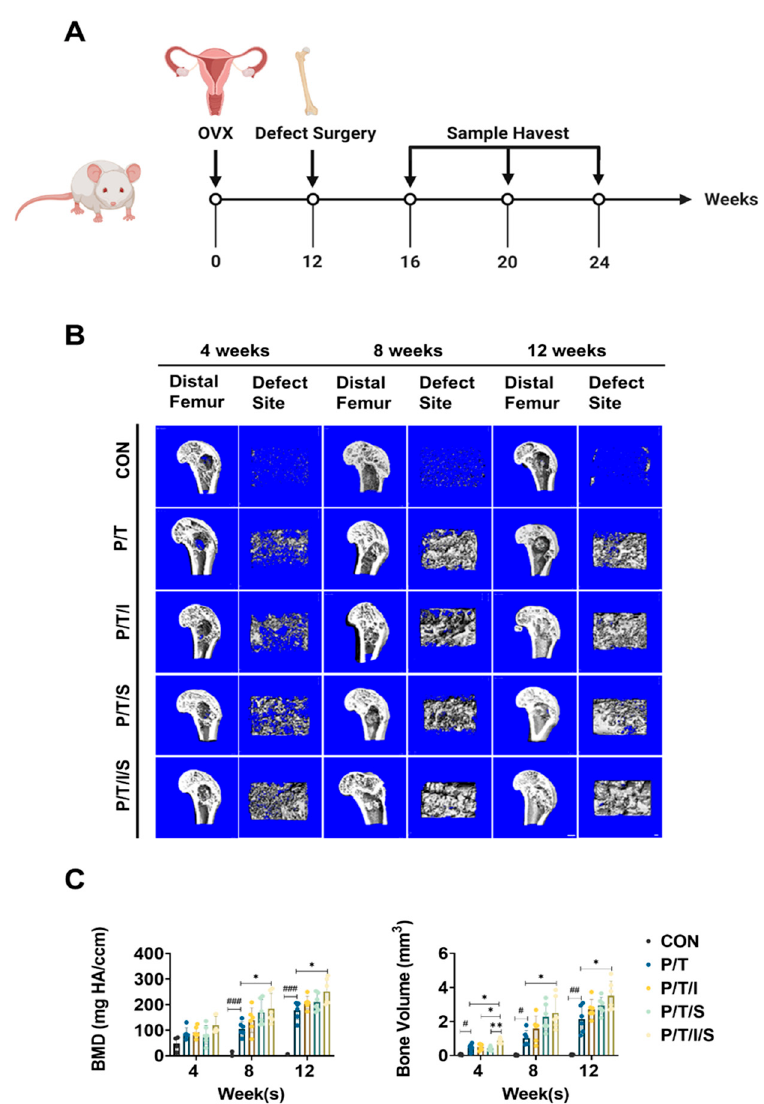
Figure 4. Osteoporotic bone regeneration in distal femoral defect. ( A ) The timeline of animal surgery. ( B ) Three-dimensional reconstructed mineralized tissue at defect sites of distal femurs at 4, 8, and 12 weeks after implantation. The scanning resolution is 17.5 µ m at 70 kV,114 µ A and the threshold is 158–1000. ( C ) Quantitative data of micro-CT. Data are shown as mean ± SD (# p < 0.05, ## p < 0.01, ### p < 0.001, denotes significant differences between the control and P/T group. * p < 0.05, ** p < 0.01, denotes significant differences among P/T, P/T/I, P/T/S, and P/T/I/S groups, one-way ANOVA with Tukey’s HSD, n =